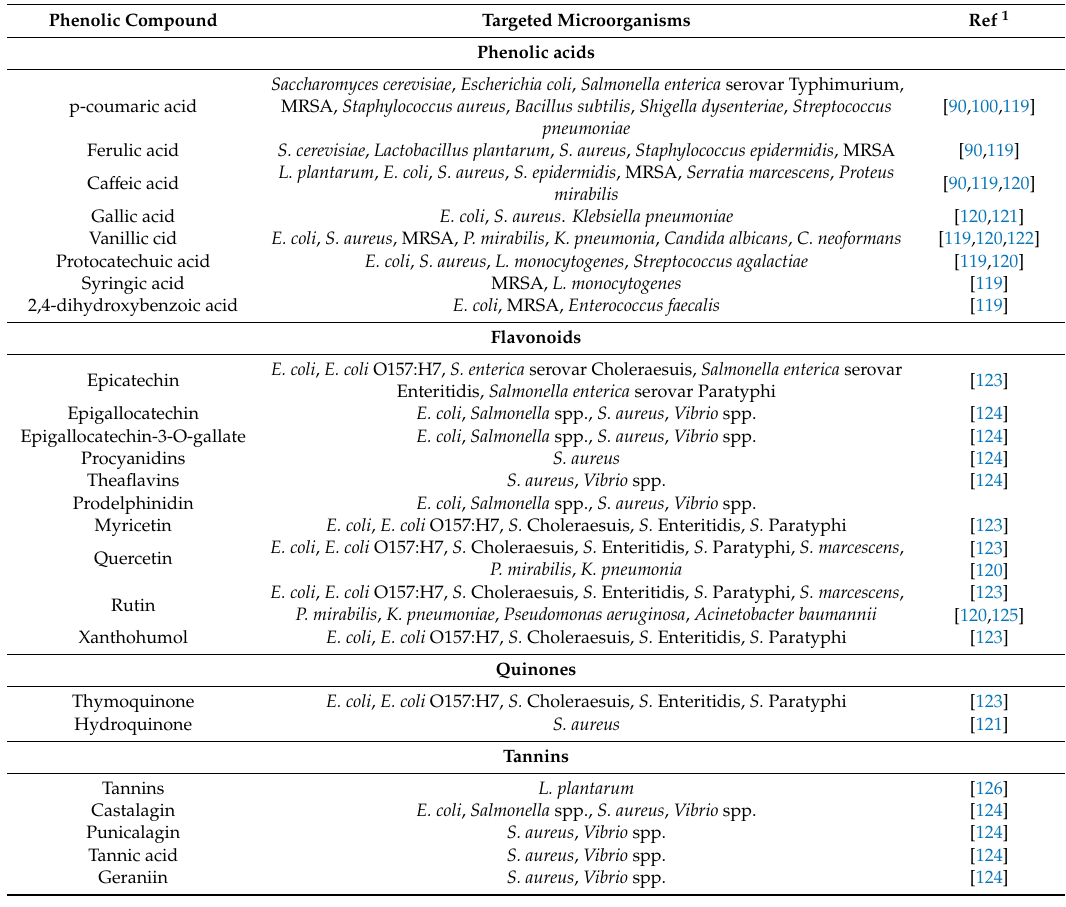
Table 2. In vitro antimicrobial activity of phenolic compounds or